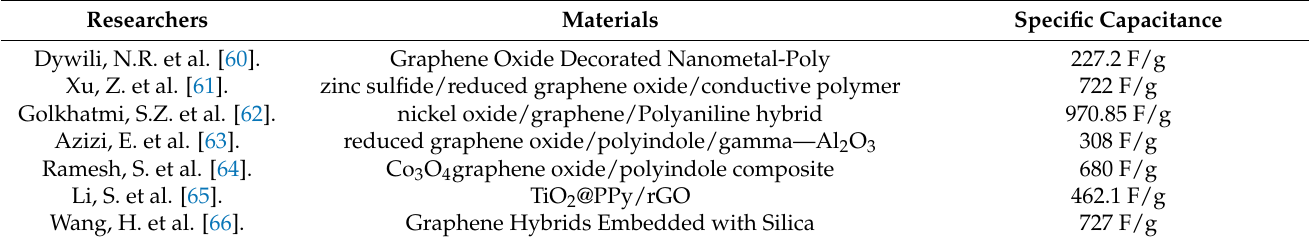
Table 4. Electrochemical performance of some of the previously reported ternary